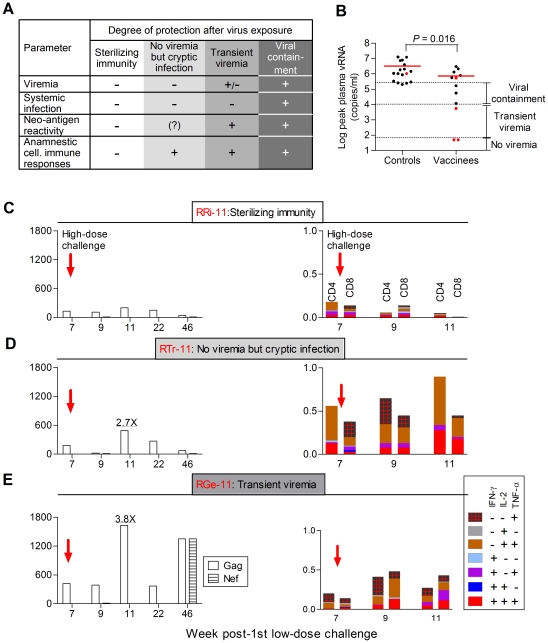
Degrees of protection.(A) Parameters to define different degrees of protection. Transient viremia, vRNA blip(s) (<104 vRNA copies/ml, which is not expected to result in seroconversion); viral containment, lowering of peak vRNA by ≥1 log vs. controls. Anti-Nef (non-vaccine component) responses were measured to detect neo-antigen reactivity. The fold increase in ELISPOTs after high-dose virus challenge compared to the day of high-dose virus challenge was determined to identify anamnestic cellular immune responses. (B) Distribution of peak vRNA. Red lines, means; dashed lines: upper, viremia 1 log lower than mean of controls; middle, 1×104 vRNA copies/ml; lower, limit of vRNA detection (50 copies/ml). (C–E) Anamnestic cellular responses and neo-antigen reactivity in the monkeys indicated. Left panels, IFN-γ ELISPOTs against SIV Gag (open bars) and Nef (striped bars, neo-antigen). Right panels, SIV Gag-specific intracellular cytokine staining.